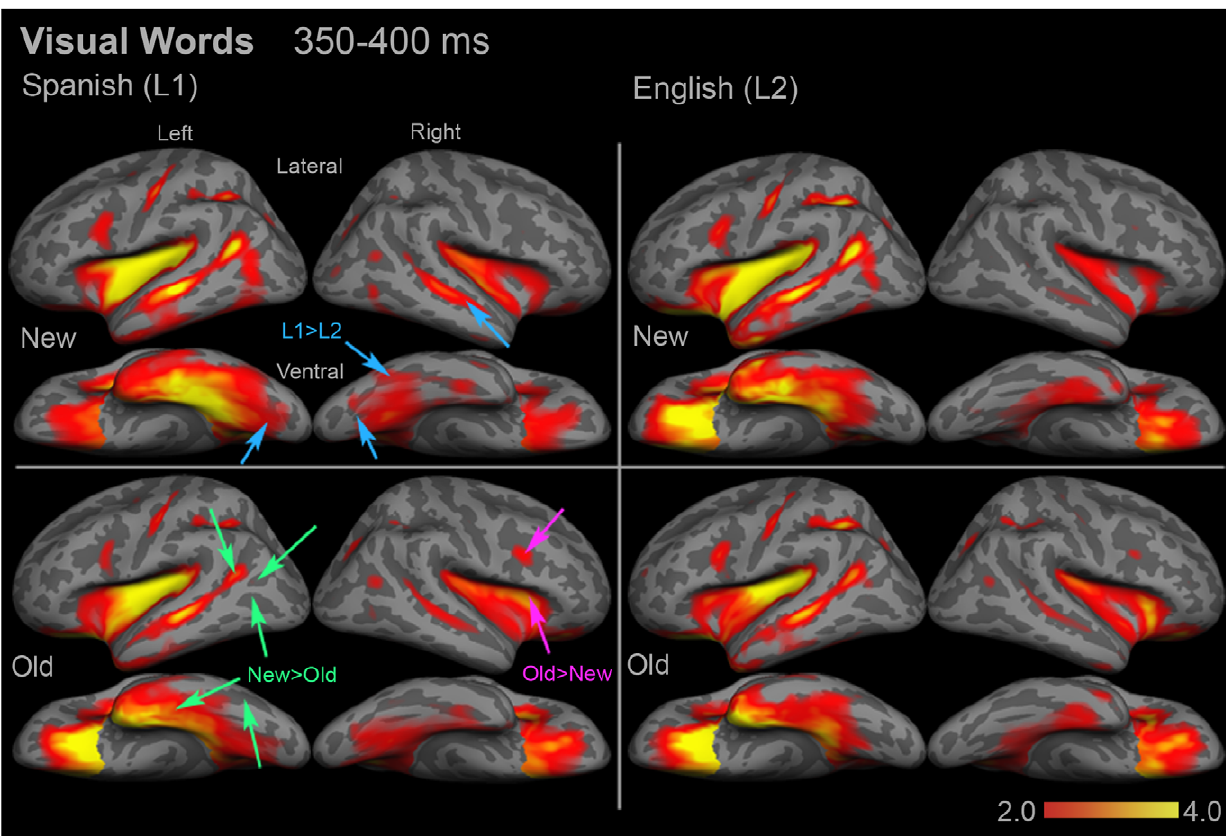
Figure 5. Group dSPM images of the mean activity evoked by visual words from 350–400 ms. Several regions in bilateral posterior and right anterior temporal cortex showed significant Spanish . English effects (blue arrows). The activity associated with the N400m in classical left temporal and frontal language areas was not significantly different between Spanish and English. Stimulus repetition effects (green arrows) were also significant in many regions, including two regions with old . new effects (magenta arrows). See Supplementary Figure S2 for ROI locations and names. Color bars represent square root of F values, which are a measure of signal-to-noise.